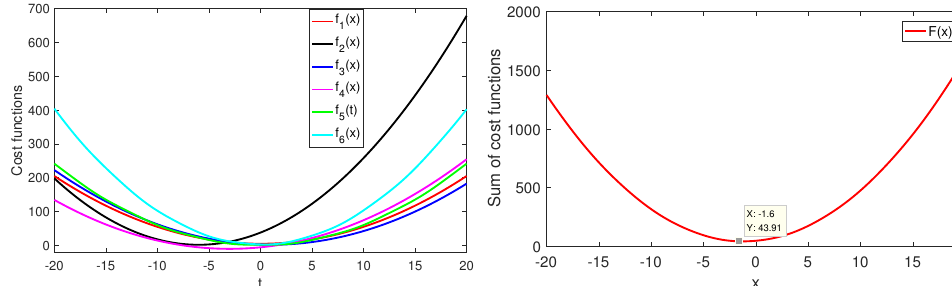
Figure 1. Evolutionary trajectory of local and global functions.